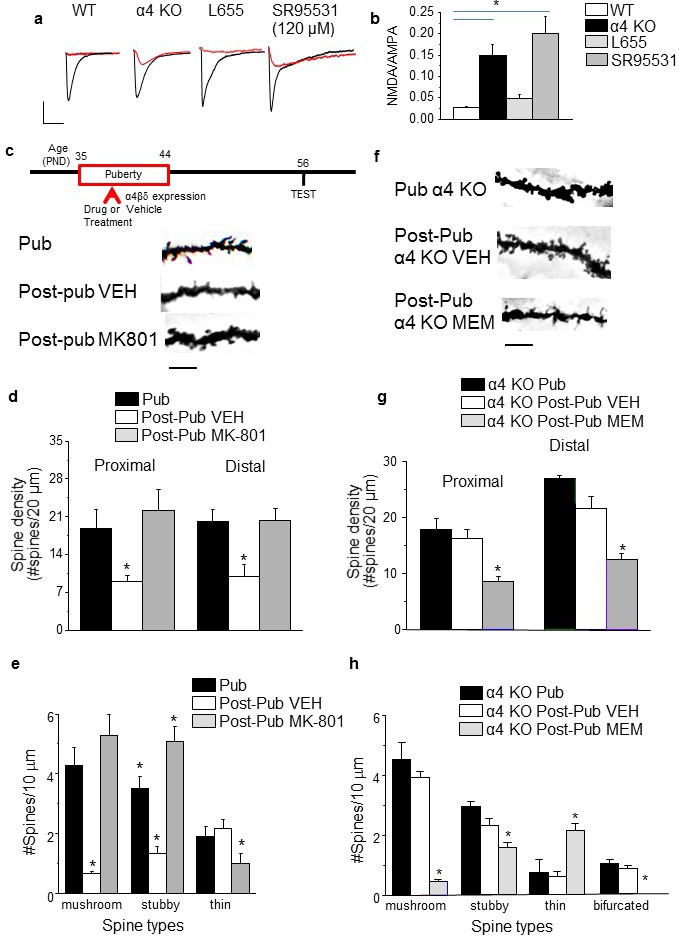
NMDA receptors maintain spines during puberty.(a) Representative EPSCs (black) and NMDA EPSCs (red) recorded during puberty in WT or α4 KO hippocampus, in some cases during α5 (50 nM L655) or total (120 μM SR95531) GABAR blockade. In all other cases, 200 nM SR95531 was bath applied block synaptic GABARs (Stell and Mody, 2002). Scale, 150 pA, 15 ms. (b) Averaged NMDA/AMPA ratios; ANOVA, F(3,31)=20.21, p=0.0001*, power=1; n=8–10 cells (mice)/group. (Figure 2—source data 1) *p<0.05 vs. WT. (c) Inset, Drug treatment during puberty (PND 35–44) was tested for its effect on post-pubertal spine density (PND 56). Z-stack images, pub and post-pub hippocampus, showing the effects of pubertal vehicle or MK-801 treatment, at a dose shown to increase NMDAR expression (Gao and Tamminga, 1995). Scale, 6 μm. (d) Averaged spine density. Proximal (left): ANOVA, F(2,32)=54.16, p<0.0001*, power=1, n= 11–12 neurons (5 mice)/group; Distal (right)l: ANOVA, F(2,32)=460.1, p<0.0001*, power=1; n=11–12 neurons (5 mice)/group. (Figure 2—source data 2) *p<0.05 vs. other groups. (e) Quantification of spine types. Mushroom, ANOVA, F(2,33)=24.7, p<0.0001*; Stubby, ANOVA, F(2,33)=25.4, p<0.0001*; Thin, ANOVA, F(2,33)=7.66, P=0.002*; power=0.9–1; n=12 neurons (6 mice) /group. *p<0.05 vs. other groups. (Figure 2—source data 3) (f) Z-stack images, pub and post-pub hippocampus, showing the effects of pubertal vehicle or memantine (MEM) treatment, a NMDAR blocker which does not alter NMDAR expression (Cole et al., 2013). Scale, 6 μm. (g) Averaged spine density. *Proximal: ANOVA, F(2,54)=64.12, p<0.0001*, power=1, n=17–20 neurons (4–5 mice) /group; Distal: ANOVA, F(2,56)=33.2, p<0.0001*, power=1, n=19–20 neurons (4–5 mice) /group. (Figure 2—source data 4) *p<0.05 vs. other groups. (h) Quantification of spine types. Mushroom, ANOVA, F(2,45)=89.9, p<0.0001*; Stubby, ANOVA, F(2,45)=9.4, P=0.0004*; Thin, ANOVA, F(2,45)=13.7, P=0.0001*; Bifurcated, ANOVA, F(2,45)=17.7, p<0.0001*; power=1, n=16 neurons (4–5 mice)/group. (Figure 2—source data 5) *p<0.05 vs. other groups.DOI:
http://dx.doi.org/10.7554/eLife.15106.01210.7554/eLife.15106.013Figure 2— source data 1.Figure 2b: NMDA EPSC/ AMPA EPSC ratios recorded from CA1 hippocampal pyramidal cells using whole cell patch clamp techniques for post-pubertal WT (a), α4 KO mice (b), WT hippocampus with SR95531 (c) and WT hippocampus with L-655,708 (L655) (d).DOI:
http://dx.doi.org/10.7554/eLife.15106.01310.7554/eLife.15106.014Figure 2—source data 2.Figure 2d: Spine counts/20 μm on dendrites of CA1 hippocampal pyramidal cells – proximal (left) and distal (right) for pubertal (Pub), Post-pubertal (Post-pub) – vehicle (VEH), and Post-pub MK-801 (treated with MK-801 during the pubertal period).DOI:
http://dx.doi.org/10.7554/eLife.15106.01410.7554/eLife.15106.015Figure 2—source data 3.Figure 2e: Spine counts/10 μm for different spine-types on dendrites of CA1 hippocampal pyramidal cells for Figure 1c for Pub, Post-pub vehicle (VEH) and Post-pub MK-801 (treated with MK-801during the pubertal period). Spines were identified as: mushroom, stubby, or thin.DOI:
http://dx.doi.org/10.7554/eLife.15106.01510.7554/eLife.15106.016Figure 2—source data 4.Figure 2g: Spine counts/20 μm on dendrites of CA1 hippocampal pyramidal cells – proximal (left) and distal (right) for α4 KO: pubertal (Pub), Post-pubertal (Post-pub) – vehicle (VEH), and Post-pub memantine (treated with memantine during the pubertal period).DOI:
http://dx.doi.org/10.7554/eLife.15106.01610.7554/eLife.15106.017Figure 2—source data 5.Figure 2h: Spine counts/10 μm for different spine-types on dendrites of CA1 hippocampal pyramidal cells for Figure 1c for α4 KO: Pub, Post-pub vehicle (VEH) and Post-pub memantine (treated with memantine during the pubertal period). Spines were identified as: mushroom, stubby, thin or bifurcated (Bif).